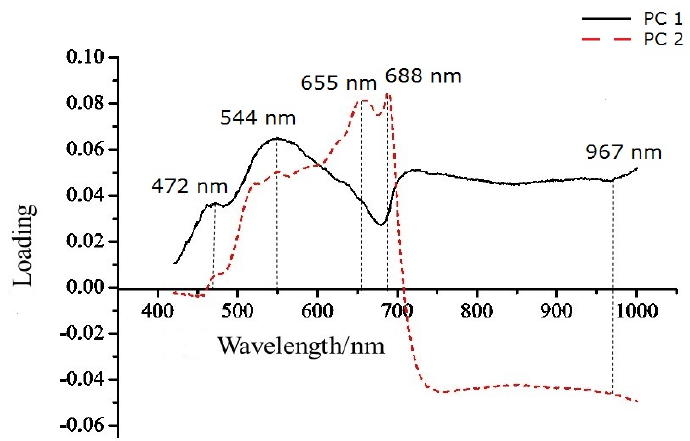
Figure 5. The loading plot of PC1 and PC2 in the spectral region of 420 to 1000 nm for modeling samples (45 normal samples and 45 bruised samples).